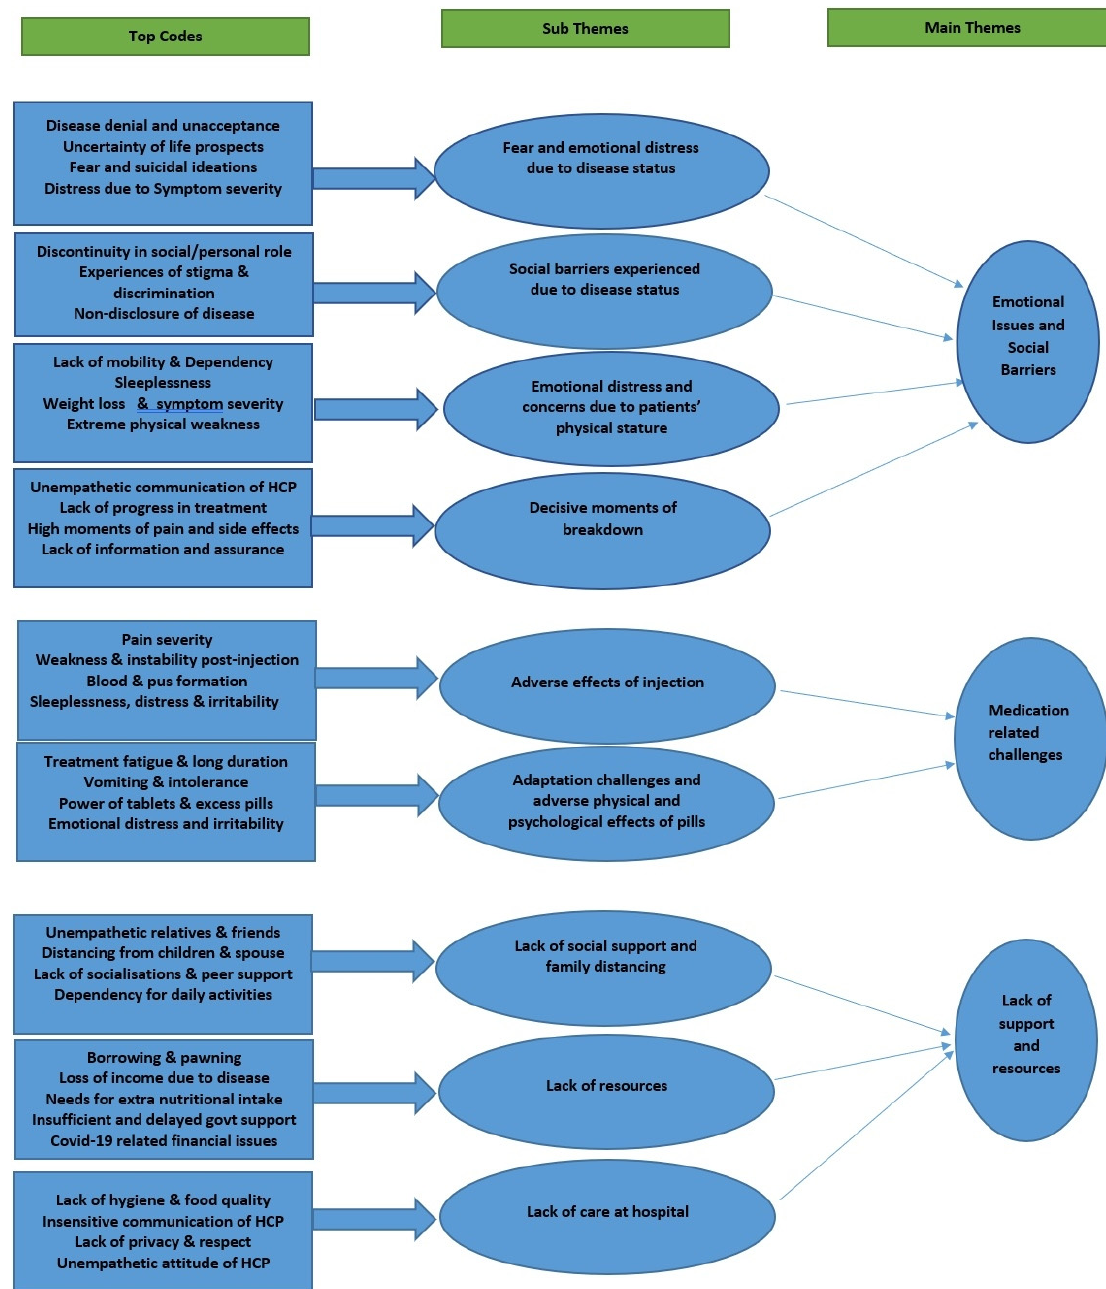
Figure 1. Hierarchical representation of the emergence of codes, sub-themes and main themes.